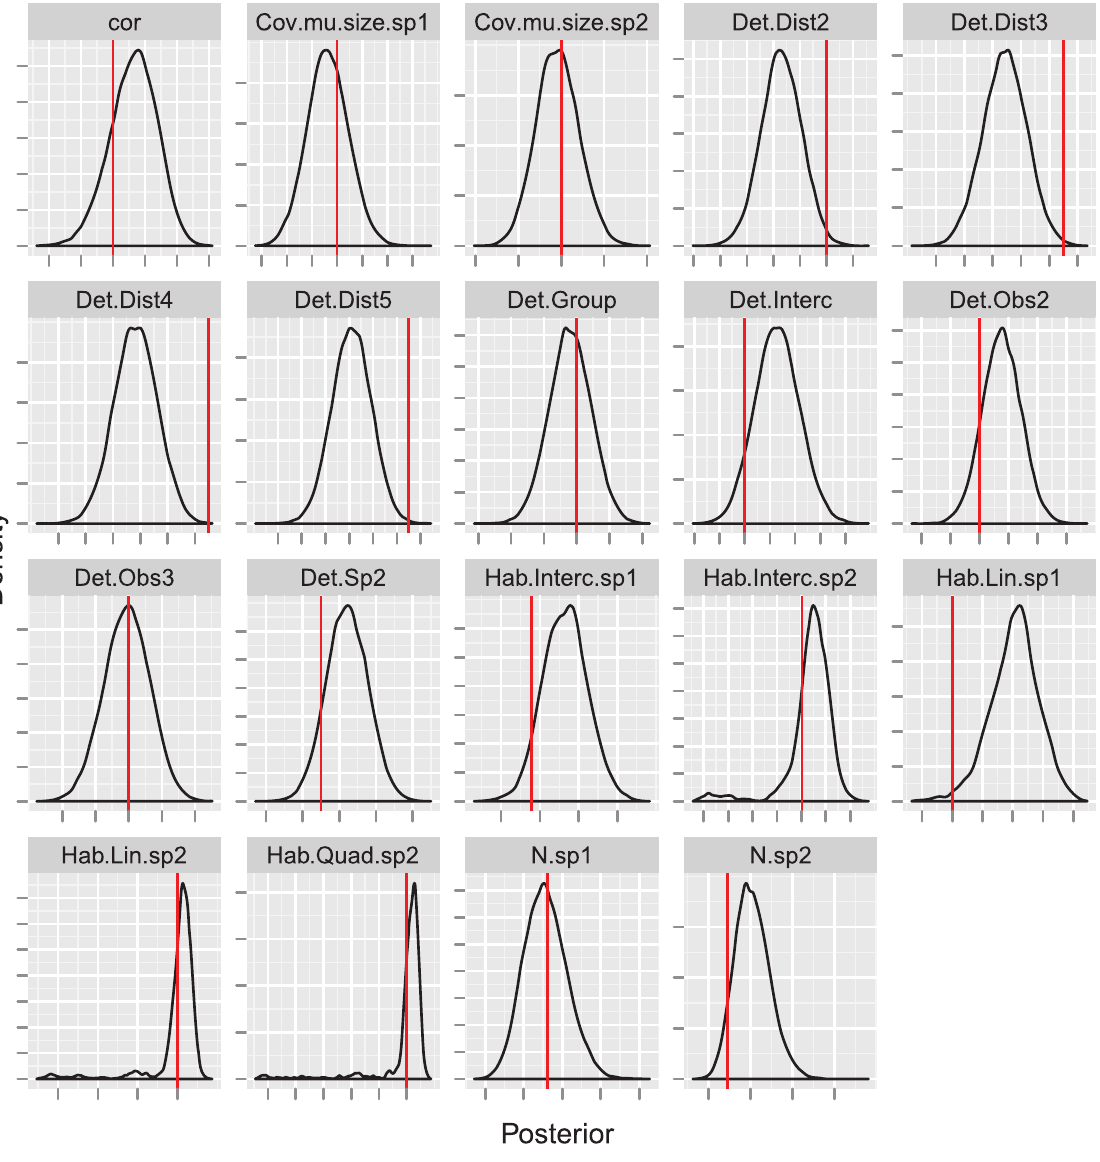
Figure 5. True values and estimated posterior distributions for simulated data. Kernel density estimates of marginal posterior distributions are indicated in black, with true values used to simulate data indicated by red, vertical lines. Parameters indexed by ‘‘Cov’’ give covariate parameters, ‘‘Det’’ give detection parameters, ‘‘Hab’’ give habitat parameters, and ‘‘N’’ gives abundance. The first panel (‘‘cor’’) gives an estimate of the observer dependence parameter. Species specific parameters are indexed by ‘‘sp1’’ (for species one) or ‘‘sp2’’ (species